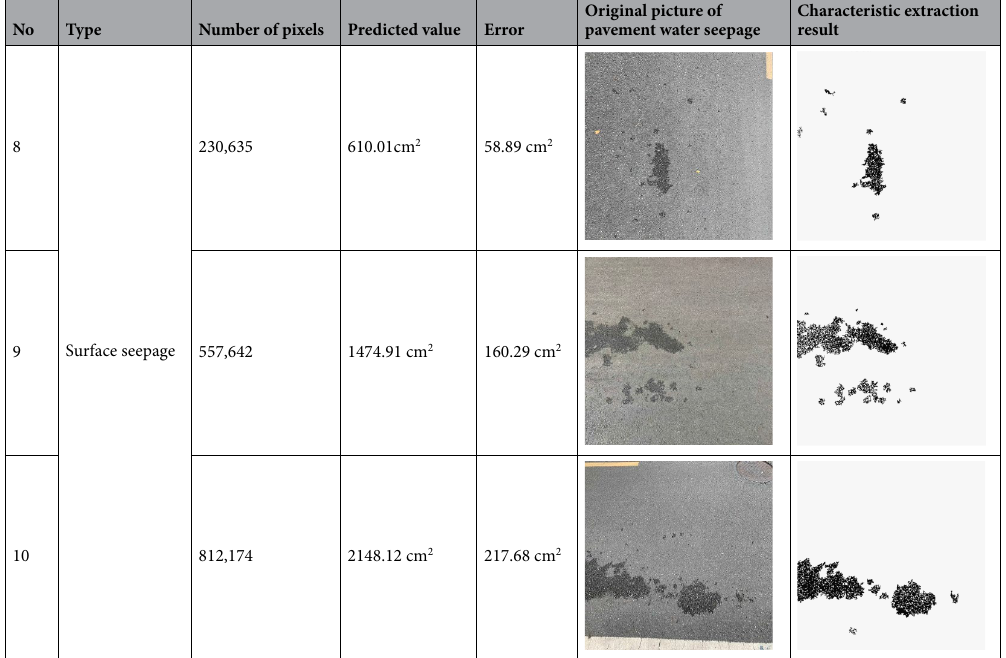
Table 4. Area calculation of the water seepage